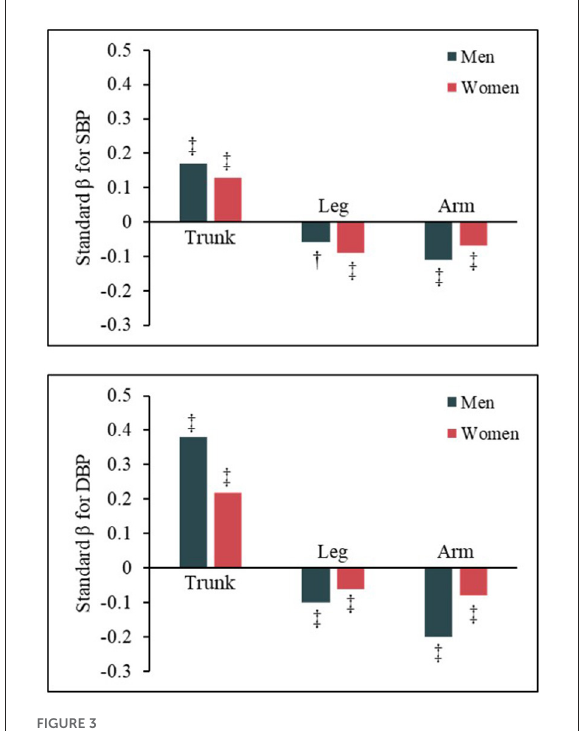
FIGURE3 Opposite impact of central and peripheral adiposity on